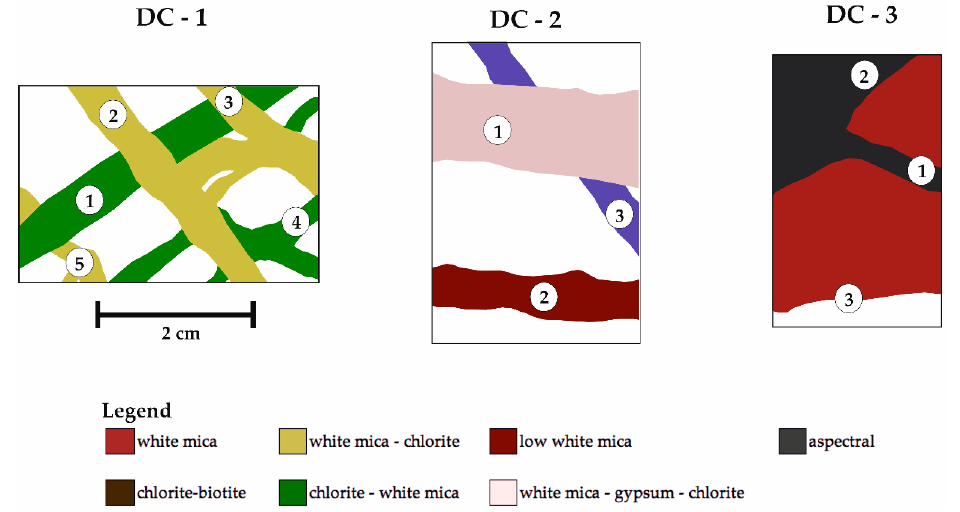
Figure 12. Simplified MLA mineral maps with markers on selected features for the vein width and azimuth validation.